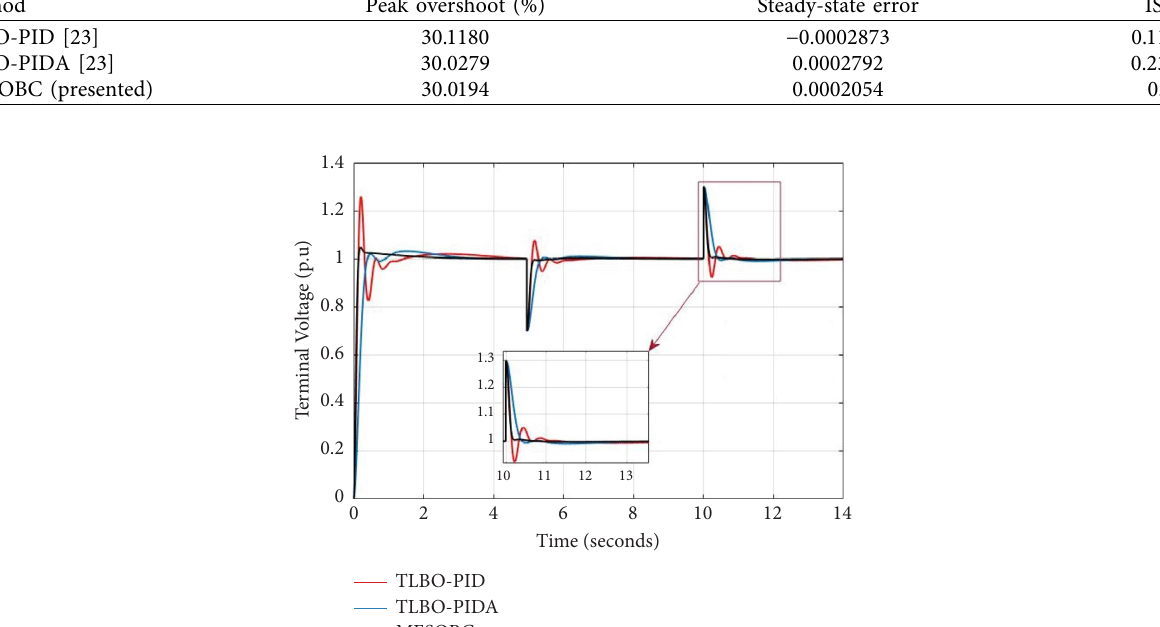
Table 4: Dynamic response specifcation of AVR under +50% parametric uncertainties in T